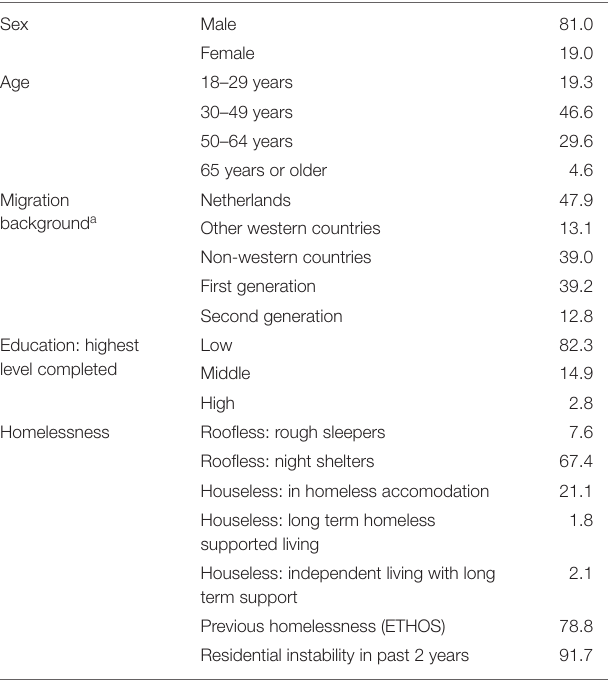
TABLE 3 | Background characteristics (in %). TABLE 4 | HOP-TR assessment